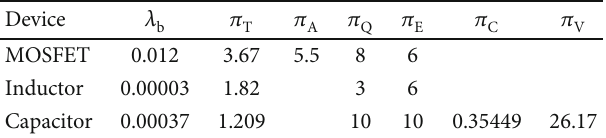
Table 6: LCL fi lter adjustment factors.